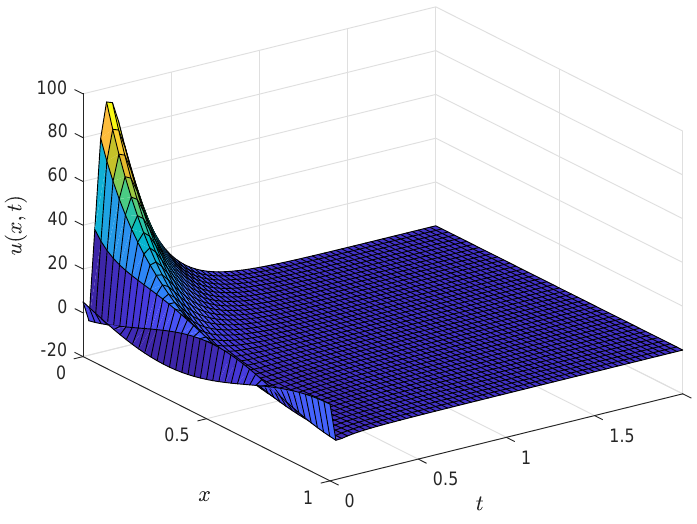
Figure 2. Closed-loop response from the solution to the R-A-D PDE with boundary